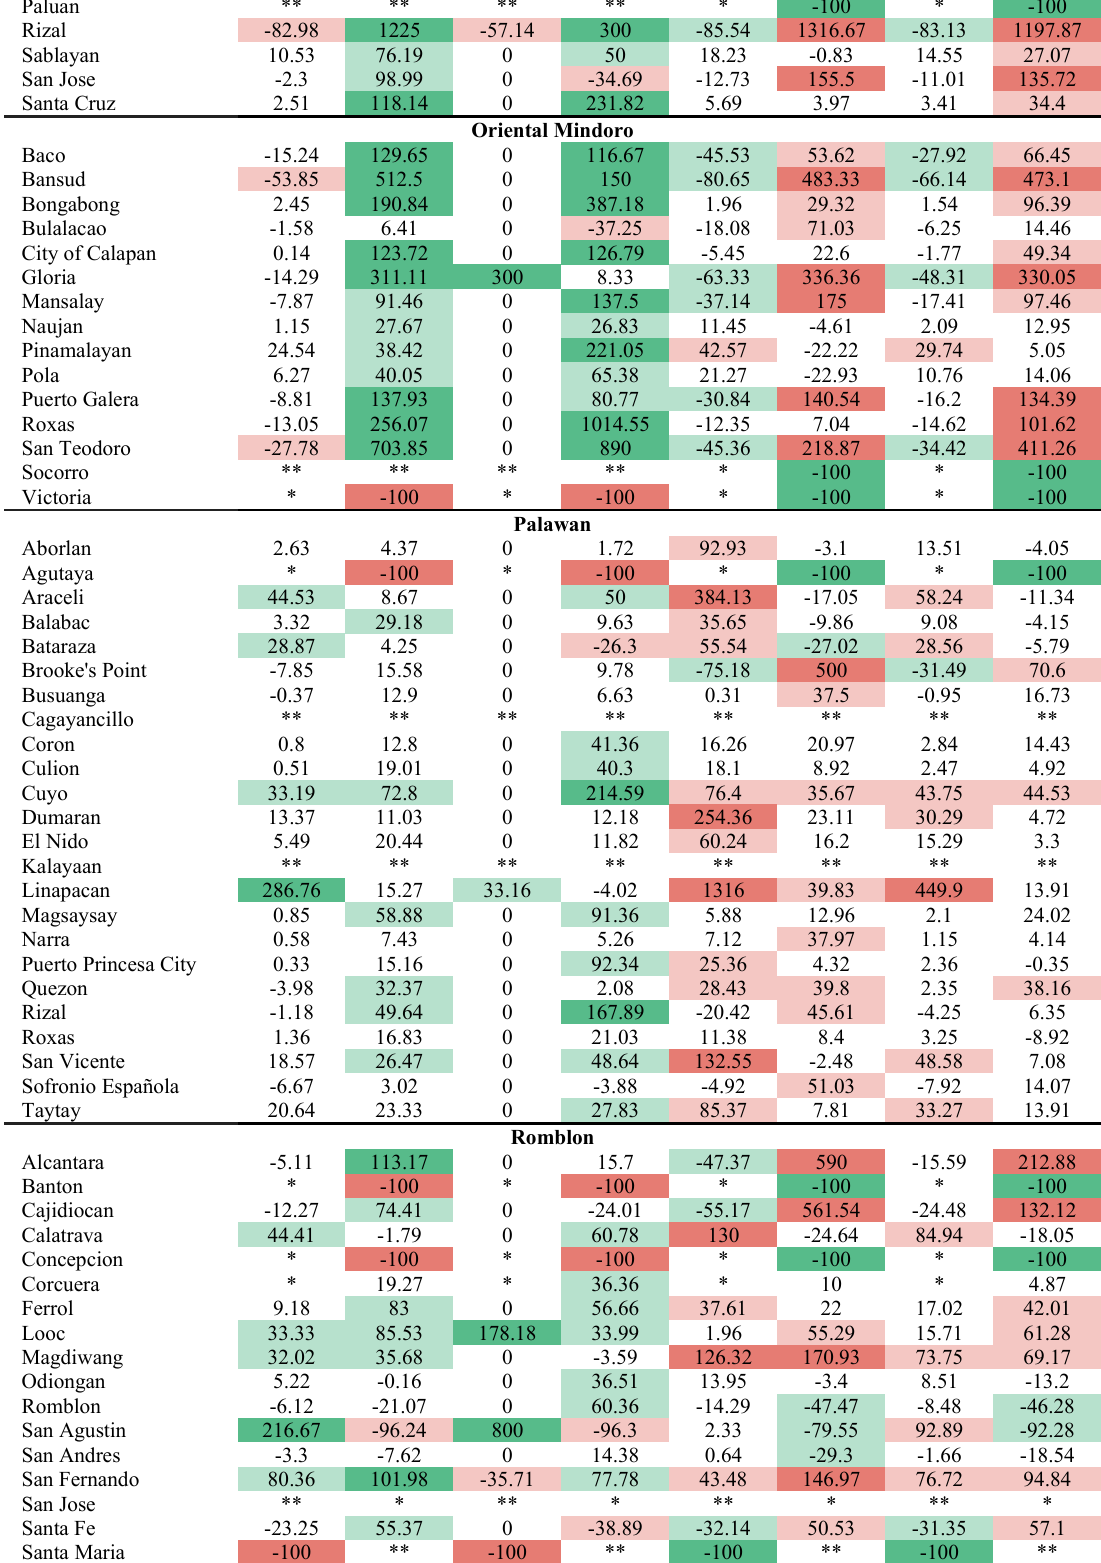
Table 13. Decadal Landscape Metric changes of each town/city from 2000. Area metric percent change highlighted in light green, green, light red, and red have values ≥ 25%, ≥ 100%, ≤ - 25%, and ≤ -100%, respectively. Fragmentation metric percent change highlighted in light red, red, light green, and green have values ≥ 25%, ≥ 100%, ≤ - 25%, and ≤ -100%, respectively. Note. *percent change from 0 to a positive value. **percent change from 0 to